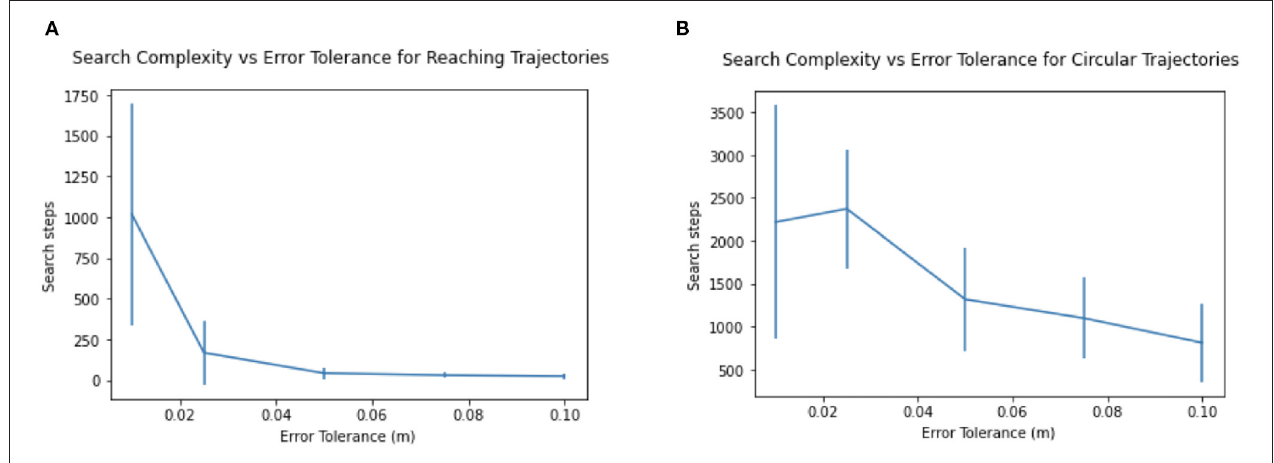
( Figure 5B ) before finding a value that caused the end effector ( Figure 5A ) to reach the desired target. The solution itself